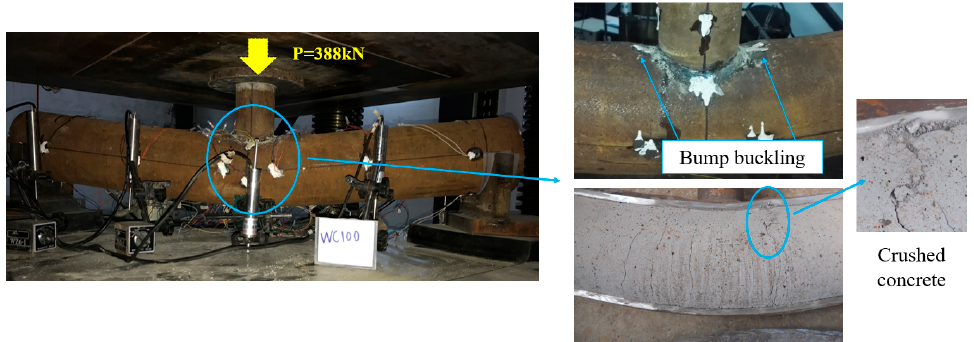
Figure 5. Typical load–midspan deflection curve.